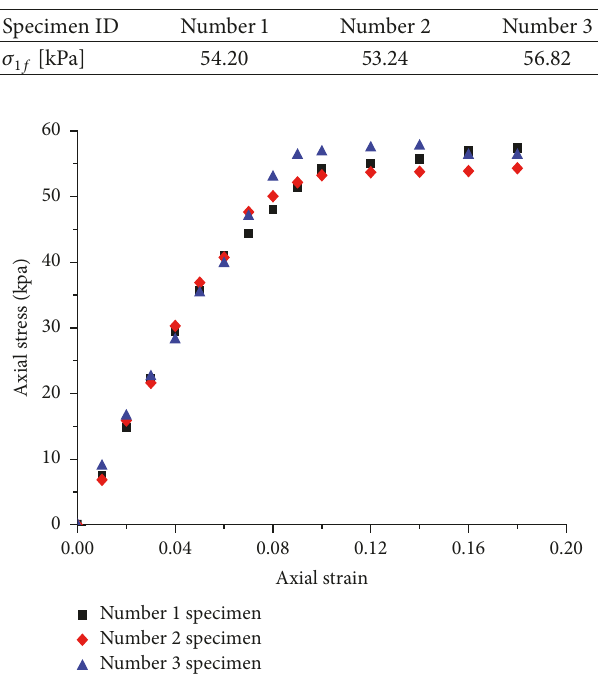
Figure 6: Axial stresses as functions of the axial strains for the three